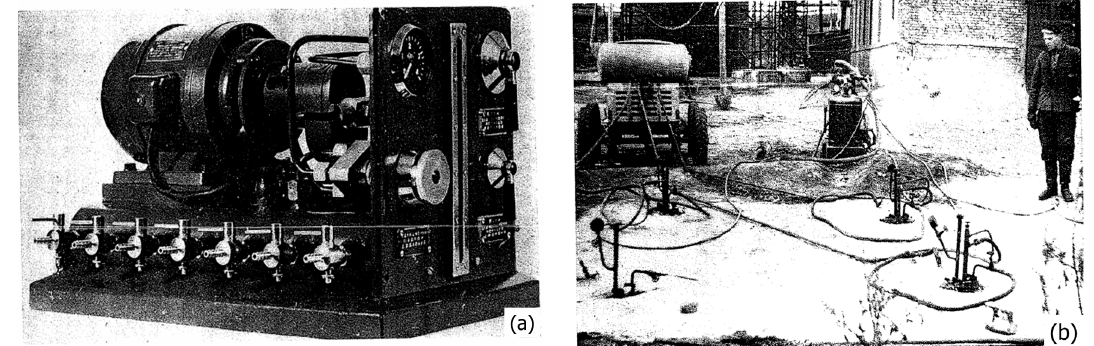
Figure 2. Photos of the ground heating equipment and application proposed by Litvinov [22]. ( a ) The equipment for mixing fossil fuel and air; ( b ) a photo of the construction the soil heating